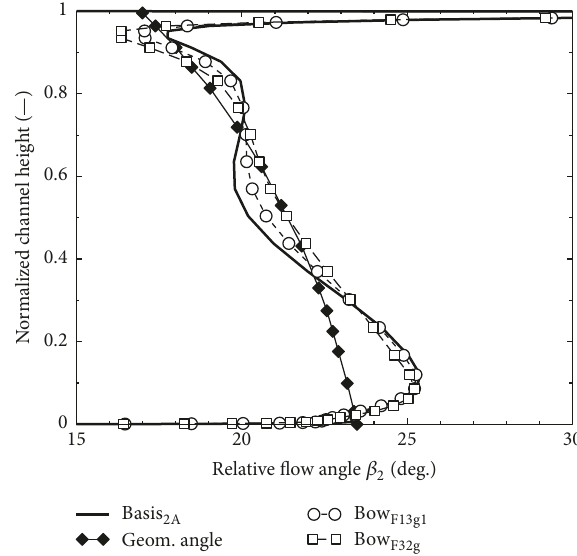
Figure 15: Circumference averaged relative exit flow angle 𝛽 2 of the rotor in position 2 (MP2).